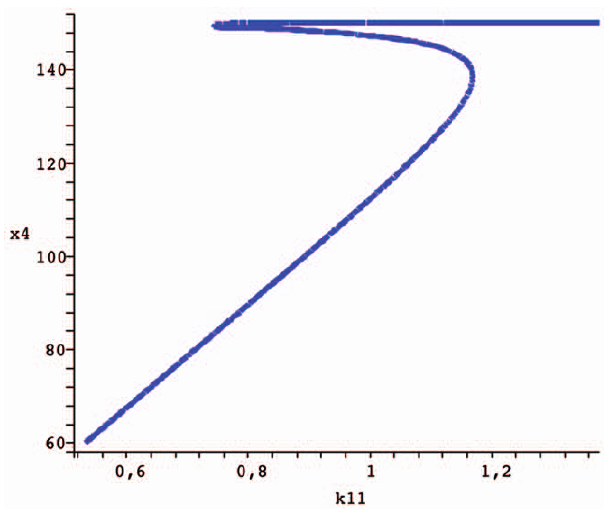
Figure 6. Bifurcation diagram X 4 vs k 11 . The remaining parameters are the same as in Figure 5 and et ~ 2 .